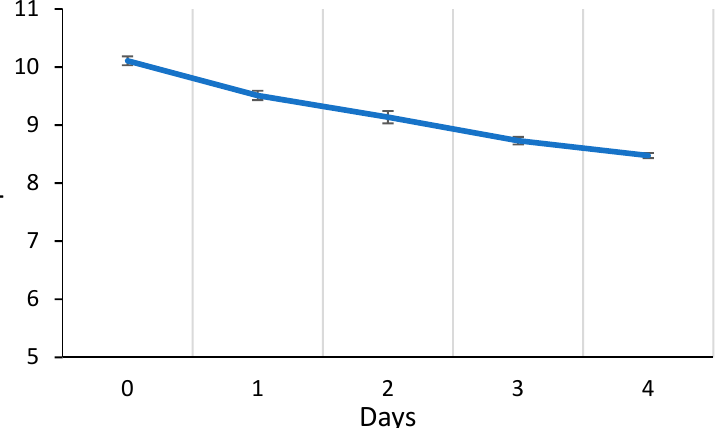
Figure 1. Surface pH values of the coating applied on poly (methyl methacrylate) specimens during the acid spraying test application. The data points and the error bars denote the mean and the standard deviation, respectively [18].